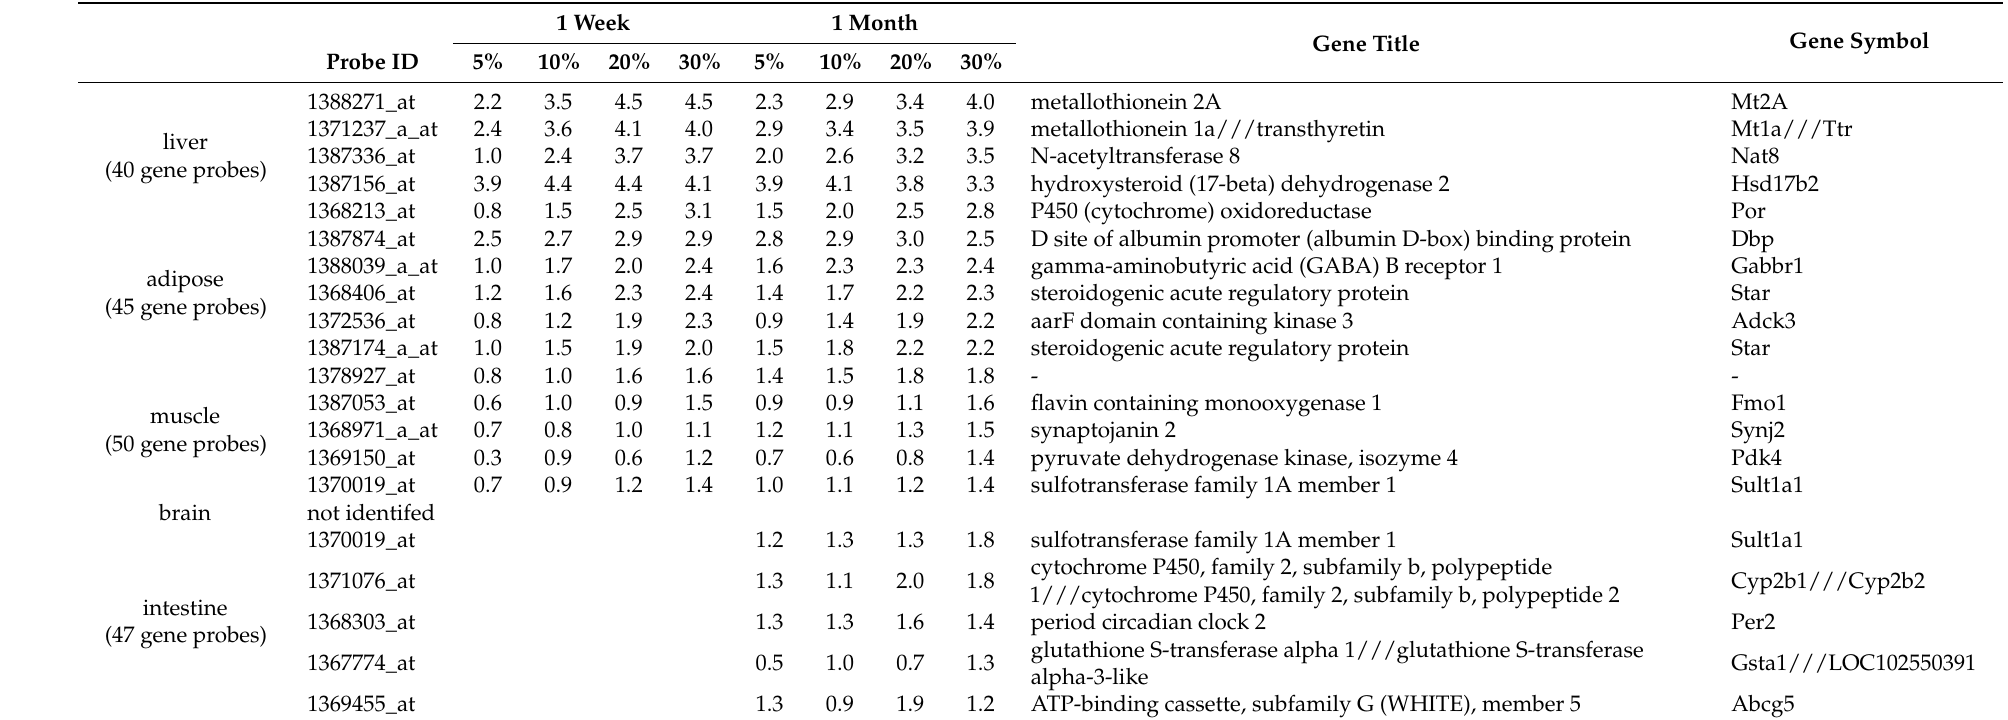
Table 2. Top five gene probes consistently up-regulated across all CR levels for each